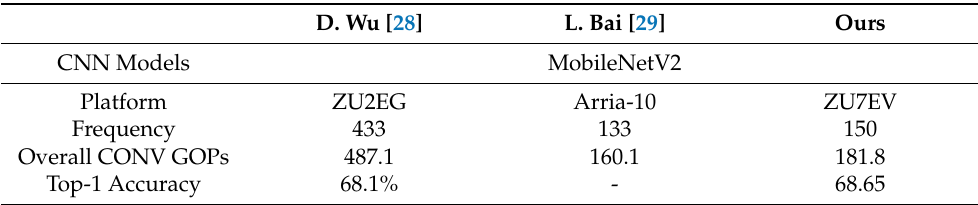
Table 3. Comparison with other FPGA